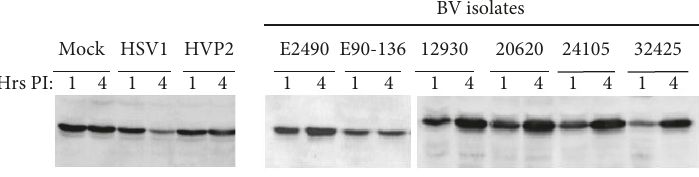
Figure 3: Lack of eIF2 𝛼 dephosphorylation by BV. Cells were harvested at 1 or 4 hrsPI and western blots were performed with antibody directedagainstphosphorylatedeIF2 𝛼 (CellSignalingTechnologies;Danvers,MA)asdescribed[25].Nochangeinthelevelofphosphorylated eIF2 𝛼 was evident in mock infected cells and the amount of phosphorylated eIF2 𝛼 decreased from 1 to 4hrsPI in HSV1 infected cells. In contrast, phosphorylated eIF2 𝛼 levels increased in BV infected